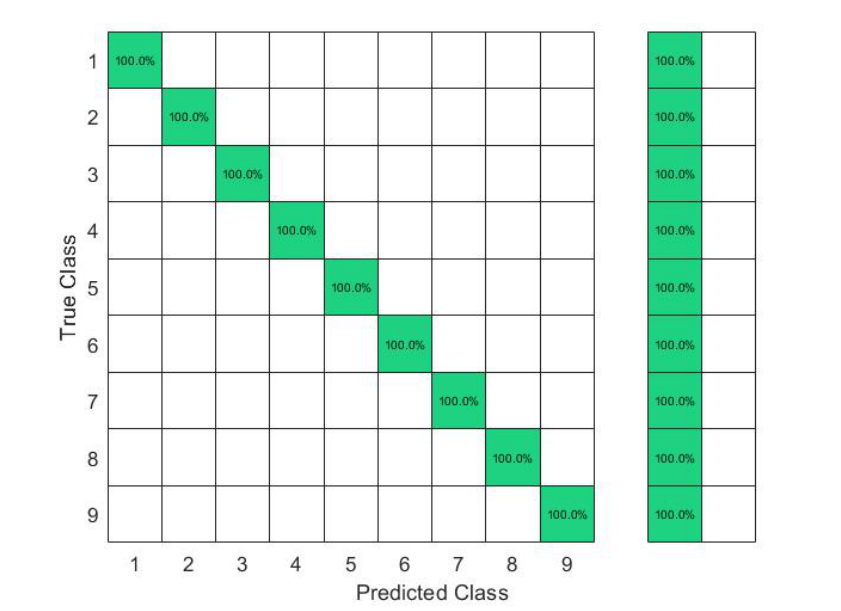
Figure 4. Confusion matrix of the KTGEL for one person for ASL numbers from 1 to 9:6 sensors.